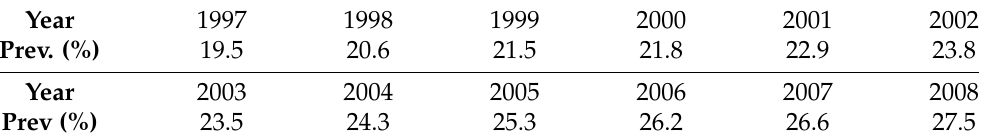
Table A5. Age-adjusted Prevalence of Obesity in US using the projected 2000 U.S. population